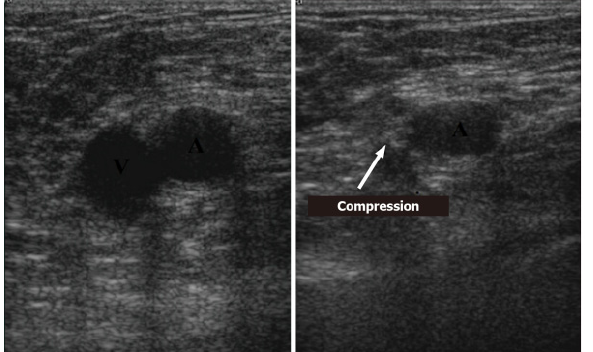
Figure 13. Compression ultrasound [Di Vilio A, Vergara A, Desiderio A, et al.: “A. Incremental value of compression ultrasound sonography in the emergency department. World J Crit Care Med.